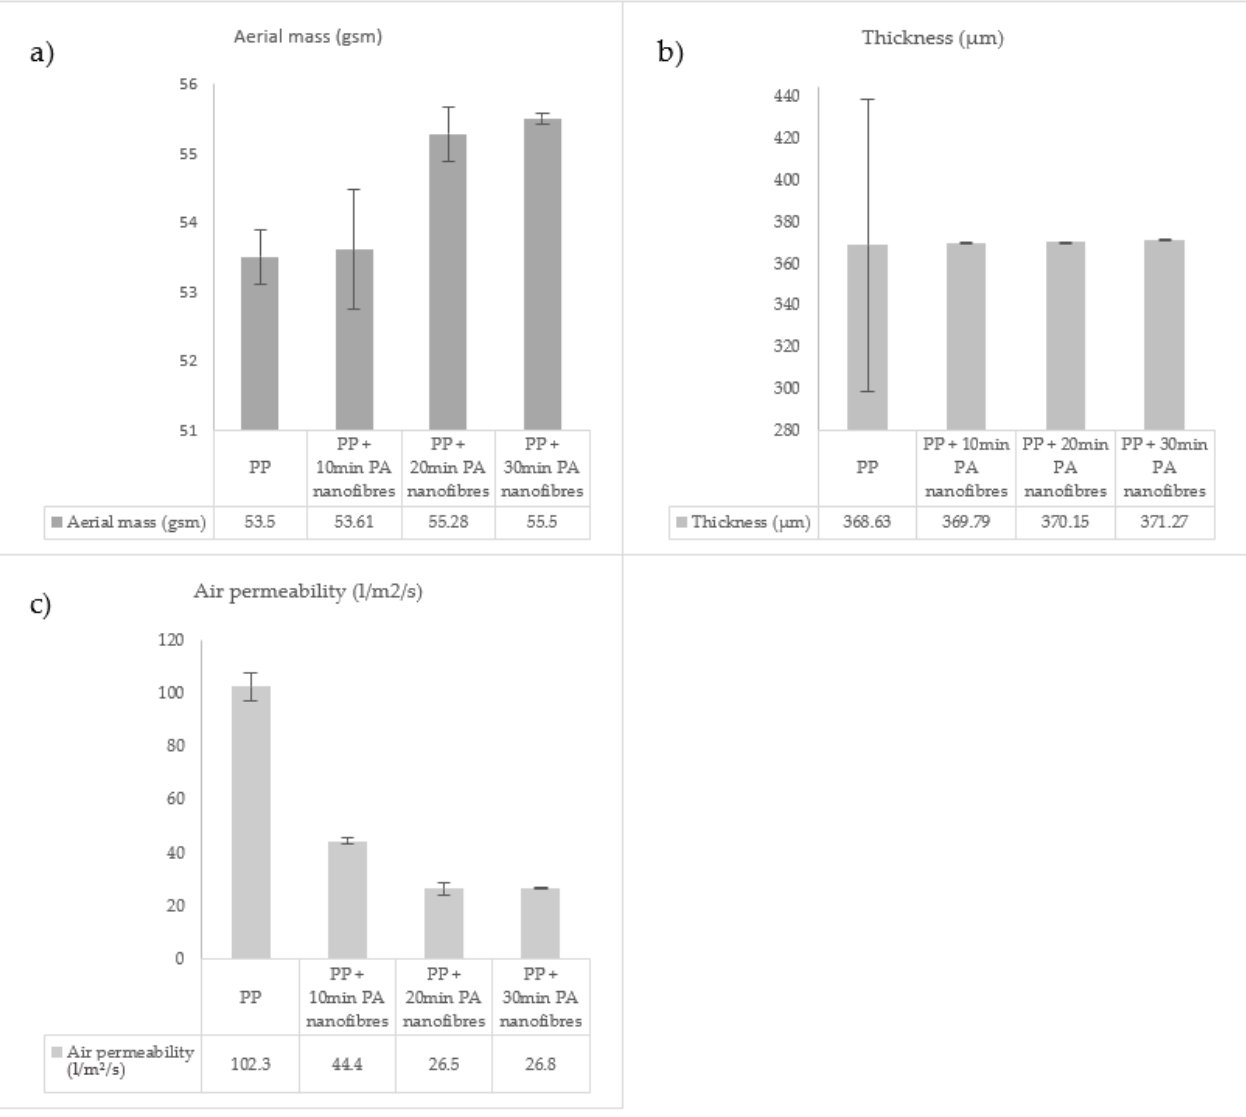
Figure 7. Aerial mass ( a ), thickness ( b ) and air permeability ( c ) of PP and PP + PA nanofibres combinations.